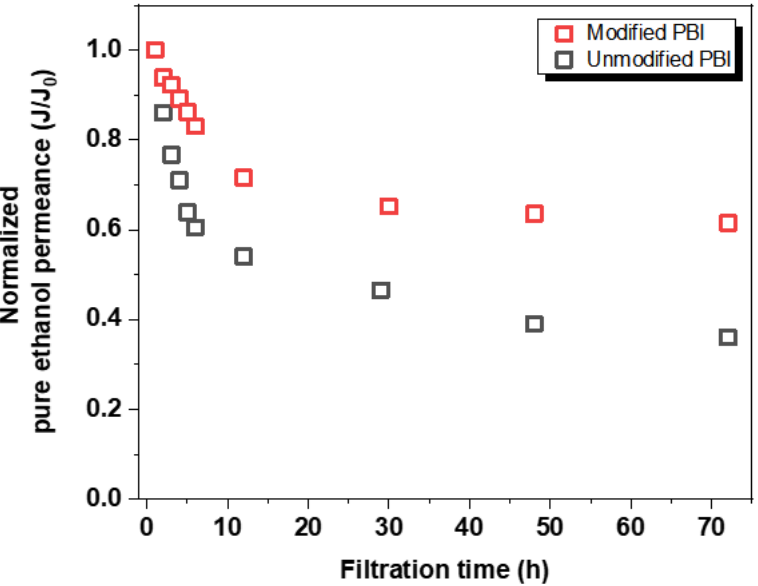
Figure 7. Long-term ethanol flux behavior of both unmodified and modified PBI membranes.